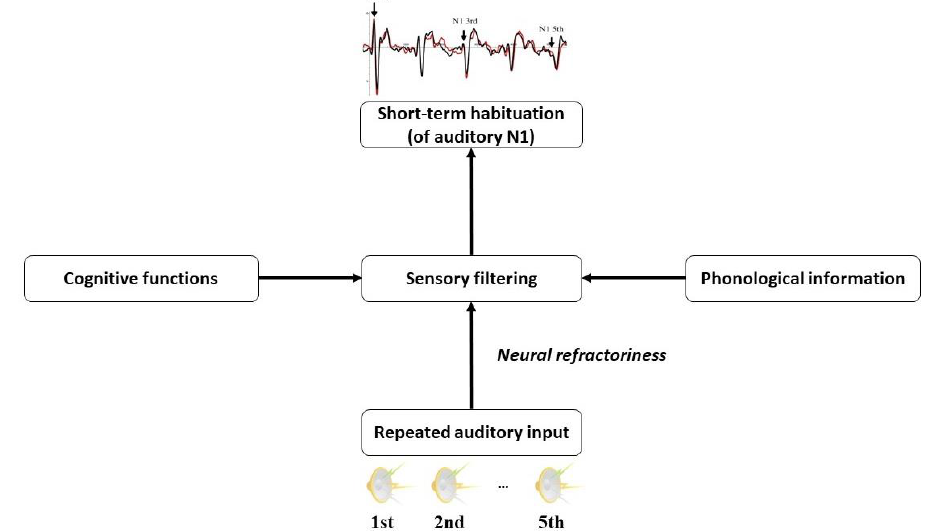
Figure 4. Demonstration of the cognitive factors’ modulation on N1 habituation via sensory filtering induced by repeated auditory stimuli. When cognitive factors are not involved in the perception of repeated auditory stimuli, N1 habituation may be subjected to neural refractoriness. However, the processing of cognitive features of the input can activate the modulators in sensory filtering which mediates between cognitive processing and bottom – up pure physiological mechanism.